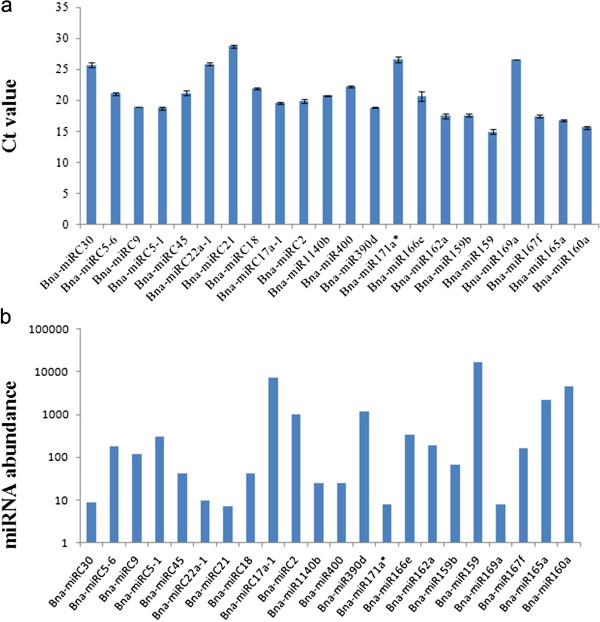
Expression levels of Bna-miRNAs by two methods. (a) Profile of qRT-PCR Ct values for Bna-miRNAs; (b) Profile of sequencing frequencies for Bna-miRNAs.